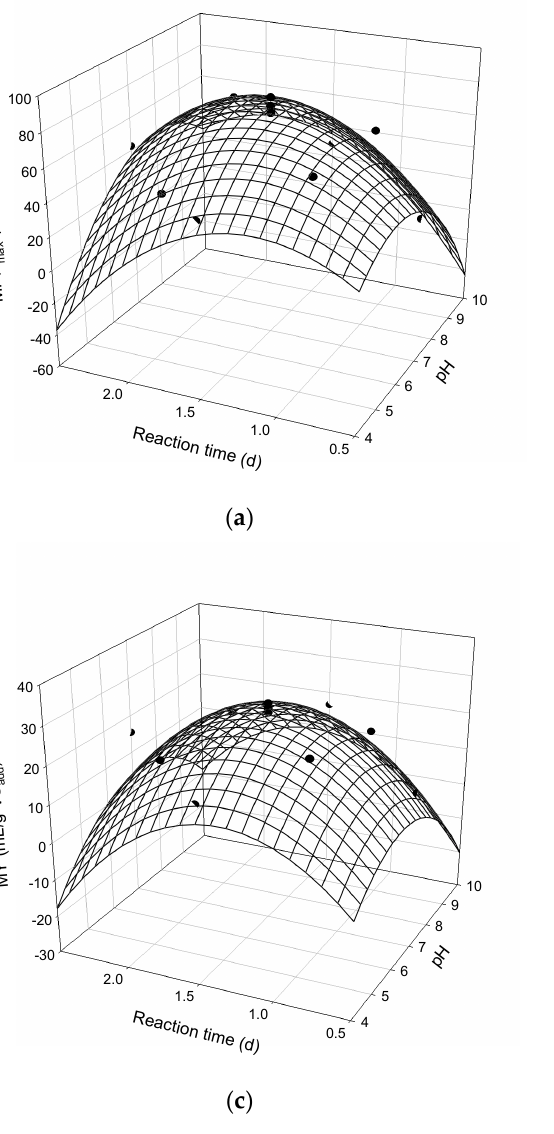
Figure 3. Methane production rate (MPR) ( a ) 3D surface plot, ( b ) contour plot and methane production yield (MY) ( c ) 3D surface plot, ( d ) contour plot at various initial pH and reaction times for the hydrolysis-acidogenesis stage.